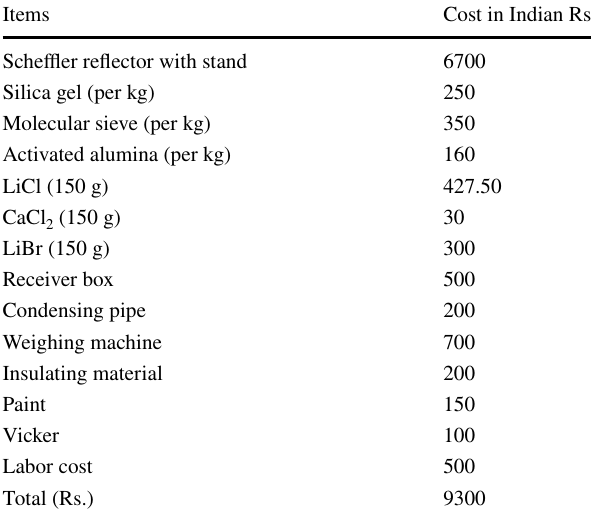
Table 1 Cost of different items in Indian